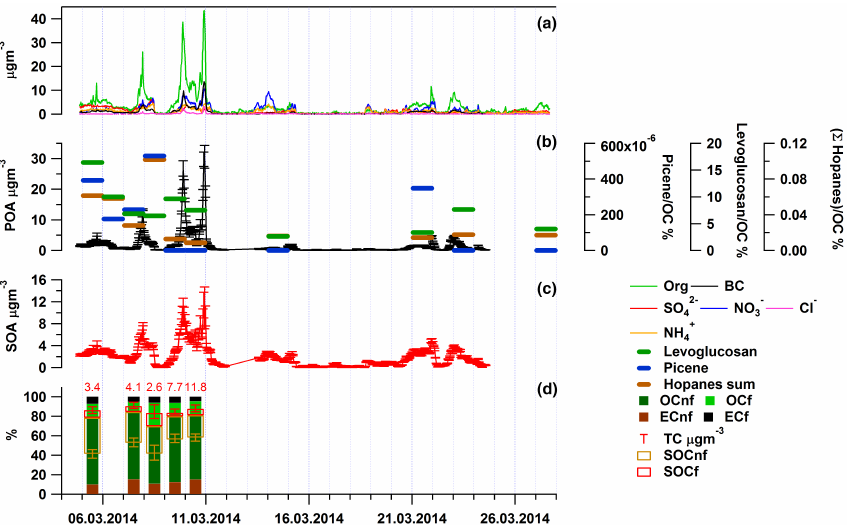
Figure 5. Average chemical composition and time series of NR-PM 1 OA for the entire study, (a, b) time series of the POA factor and percent contribution of the corresponding tracer species (levoglucosan, picene and hopanes) to total OA, (c) time series of the SOA factor, (d) relative source apportionment of TC during the BB event. Numbers indicate the total carbon absolute concentrations in µgm − 3 , variations of the mass concentrations of the SOC f and SOC nf (the whiskers above and below the boxes indicate the 1st and 3rd